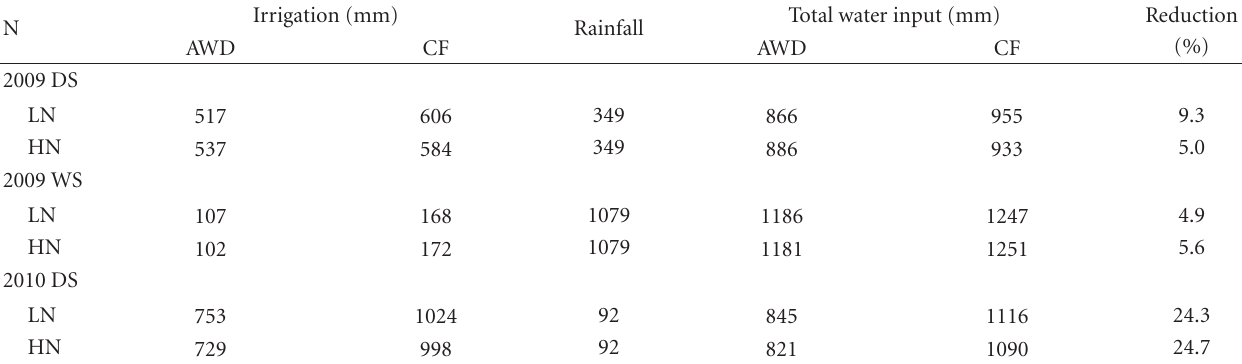
Figure 1: Daily maximum and minimum temperatures and solar radiation during rice-growing seasons at the IRRI farm in 2009 DS (a), 2009 WS (b), and 2010 DS (c). Table 1: Rainfall and total water supply (irrigation plus rainfall) of the four rice varieties grown under two water management treatments and two N rates at IRRI farm in the three consecutive seasons.